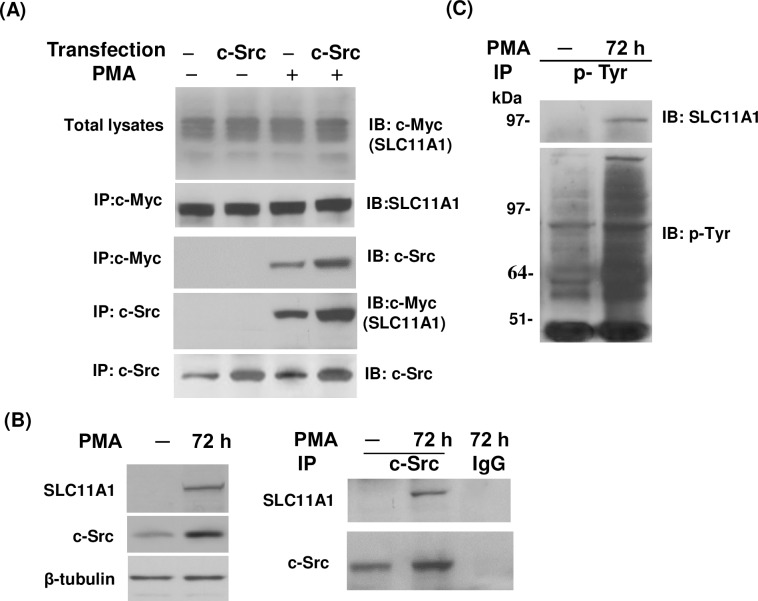
PMA-induced association of SLC11A1 with c-Src in intact cells.U937-SLC11A1 cells were transiently transfected with a vector pCB6-Src to express wild-type c-Src. Untransfected cells were used as a control. Both transfected and untransfected cells were treated with or without PMA (10ng/ml) for 48 hrs as indicated. (A) Cell lysates were prepared and immunoprecipitated with a mouse monoclonal antibody (9E10) directed against the c-Myc tag or anti-c-Src antibodies. Immunoprecipitates were analyzed by Western blot analysis as indicated. (B) HL-60 cells were either treated or untreated with PMA (10ng/ml) for 72 hrs. Cell lysates were prepared and the expression of SLC11A1 and c-Src in response to PMA treatment were detected by using Western blot analysis (left panel). Protein extracts were immunoprecipitated with a c-Src antibody. The immunocomplexes were detected by immunoblotting with an antibody against SLC11A1 and reprobed with an antibody against c-Src (right panel). (C) HL-60 cells were treated with or without PMA (10ng/ml) for 72 hrs. Cell lysates were immunoprecipitated with an anti-phosphotyrosine antibody (4G10). Tyrosine phosphorylation of SLC11A1 was detected by Western blot analysis using a rabbit anti-SLC11A1 antibody. The Western blots were stripped and re-probed with 4G10 for tyrosine-phosphorylated proteins.